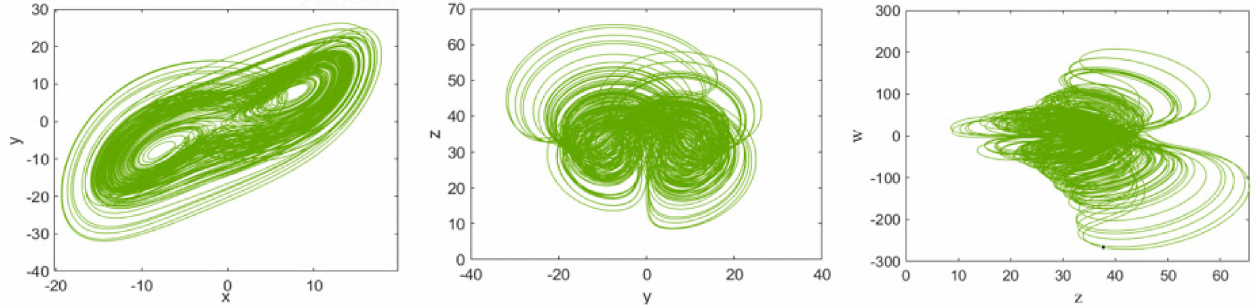
Figure 2. Phase plots of the fractional memristor system with q =